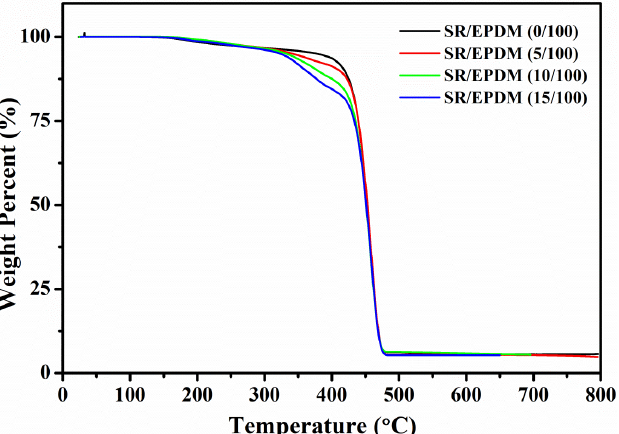
Figure 7. Thermogravimetric analysis of the SR/EPDM composites.